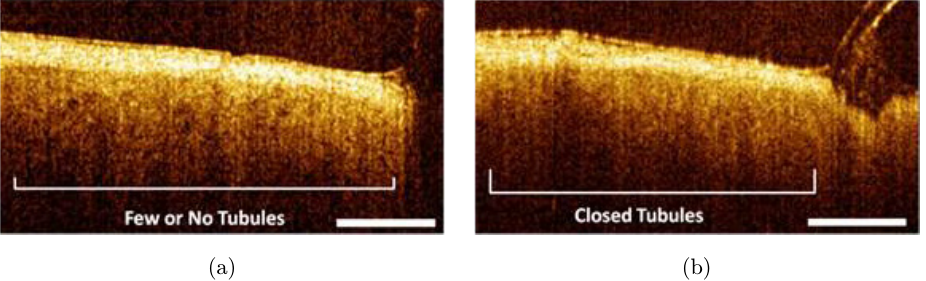
Fig. 4. Examples of a variation of in vivo OCT images of human kidney for tubule size/shape and tubule density/uniformity. tubule size/shape: (b) poor (d) moderate (f) good. Tubule density/uniformity: (a) poor (c) moderate (e) good. Scale bar ¼ 500 (cid:1)